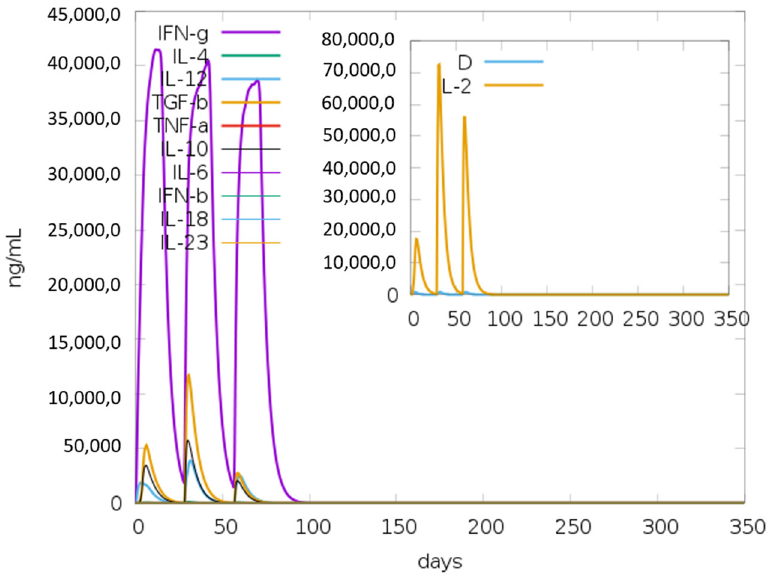
Figure 10. Graphical representation about the production of various immunogenic molecules such as interferons (IFNs) and interleukins (IL); the small graph has a dark blue line, which shows the dangerous level, but that line is almost straight, showing there is no overreaction of vaccine.